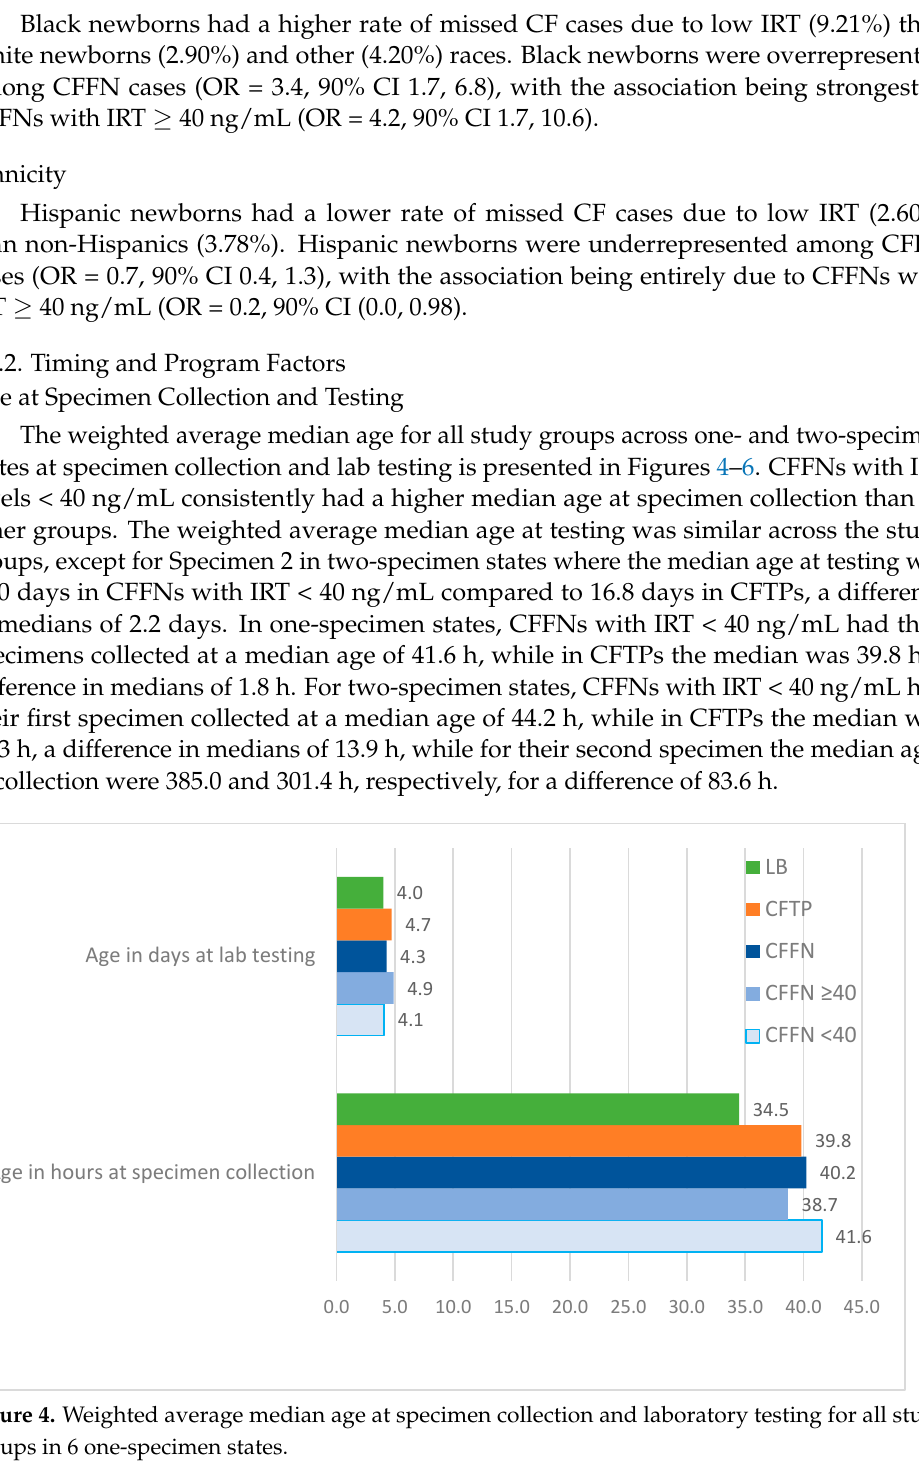
Figure 5. Weighted average median age at specimen collection and laboratory testing for all study groups in 3 two-specimen states: Specimen 1. (Median ages for CFFNs with IRT ≥ 40 ng/mL based on 2 states).